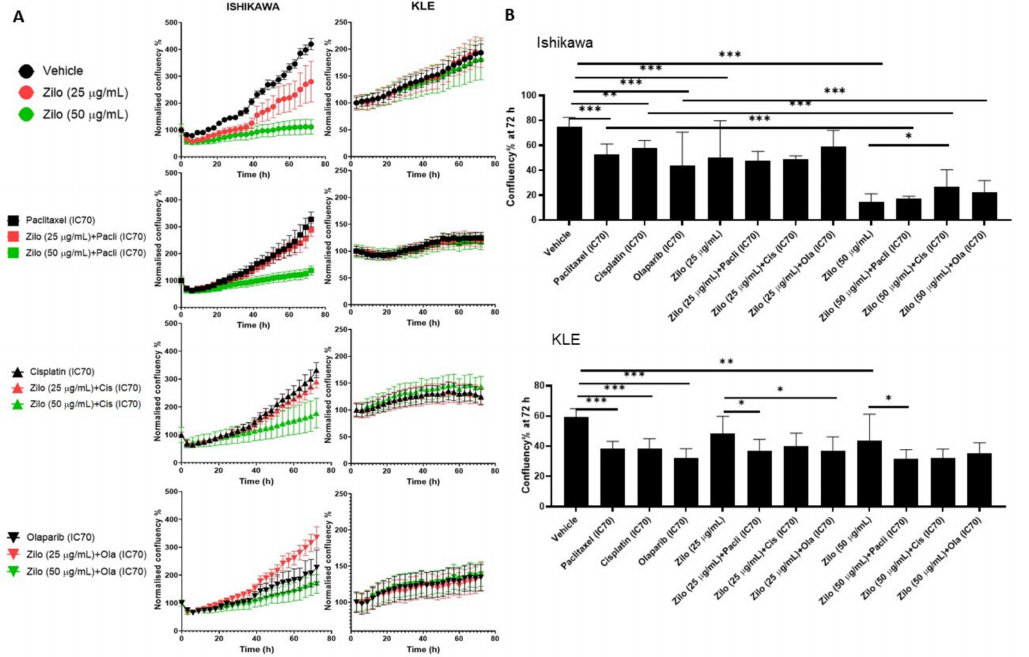
Figure 3. The effect of zilovertamab (“zilo”) +/ − Paclitaxel, Cisplatin, Olaparib at IC70 on endome- trial cancer cell lines Ishikawa and KLE. ( A ). Confluency of cell lines over 72 h of treatments analysed by IncuCyte S3. ( B ). Differences in cell confluency following each treatment compared with con- trol (vehicle for single treatment, single arm for combined therapies) at 72 h. Significance of the comparisons was assessed using two-way ANOVA with a Dunnett/Tukey correction for multiple comparisons. * Adjusted p < 0.05 ** Adjusted p < 0.01, *** Adjusted p < 0.001. For each panel, n = 5, error bar =